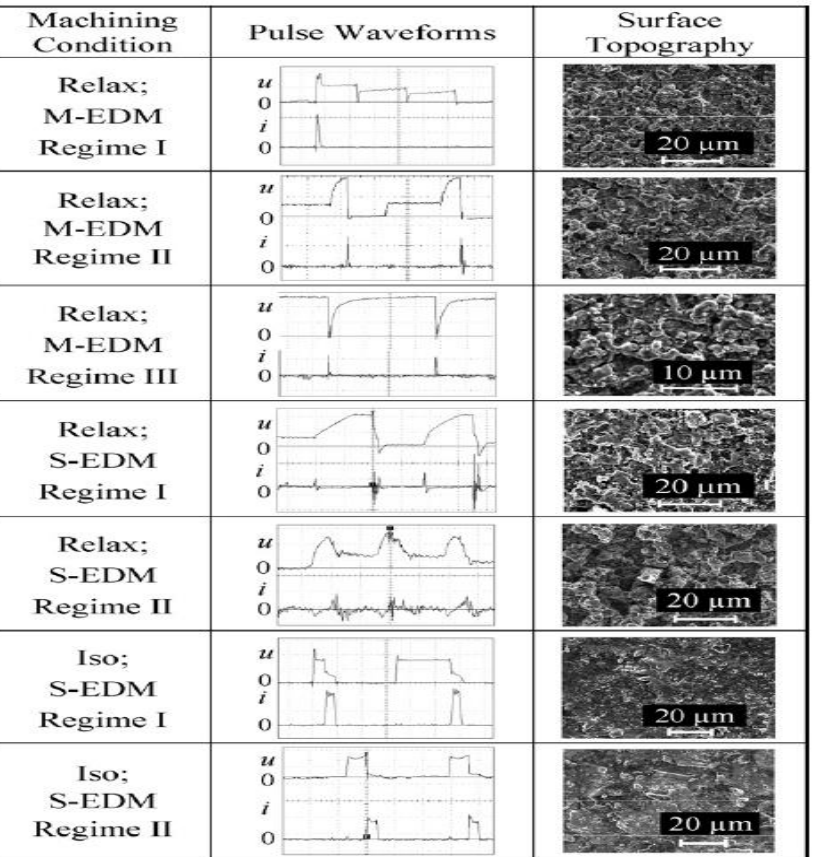
Figure 18. Pulse shapes and corresponding surface topographies. (Reproduced with permission from [140]).